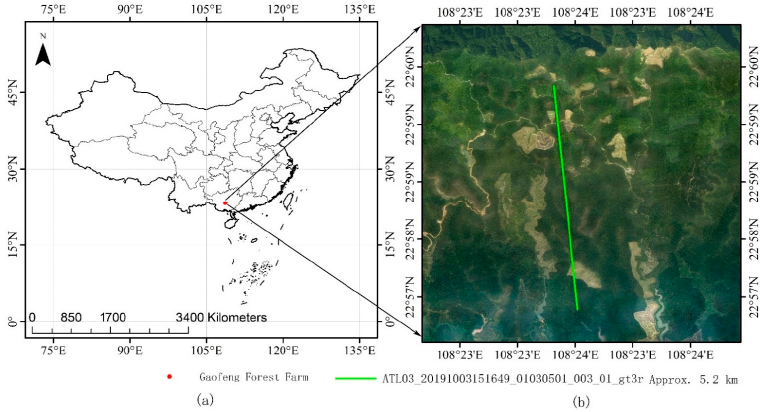
Figure 1. Location of study area: ( a ) location of the forest farm site in China; ( b ) a subset of the footprint of the ICESat–2 data with 5.2 km (where 5.2 km is the distance of that along ‐ track).